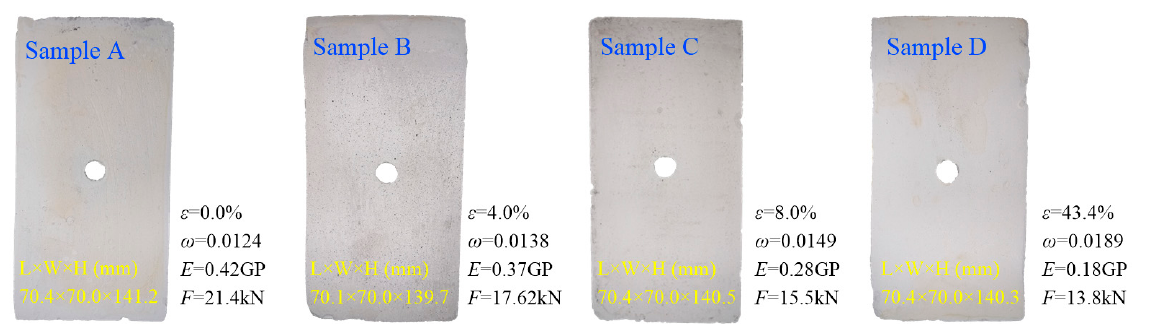
Figure 3. The four specimen groups with their physical parameters.